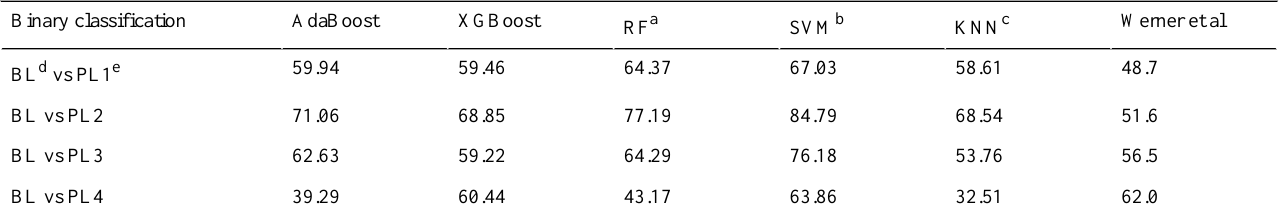
Table 7. Validation accuracy of top 8